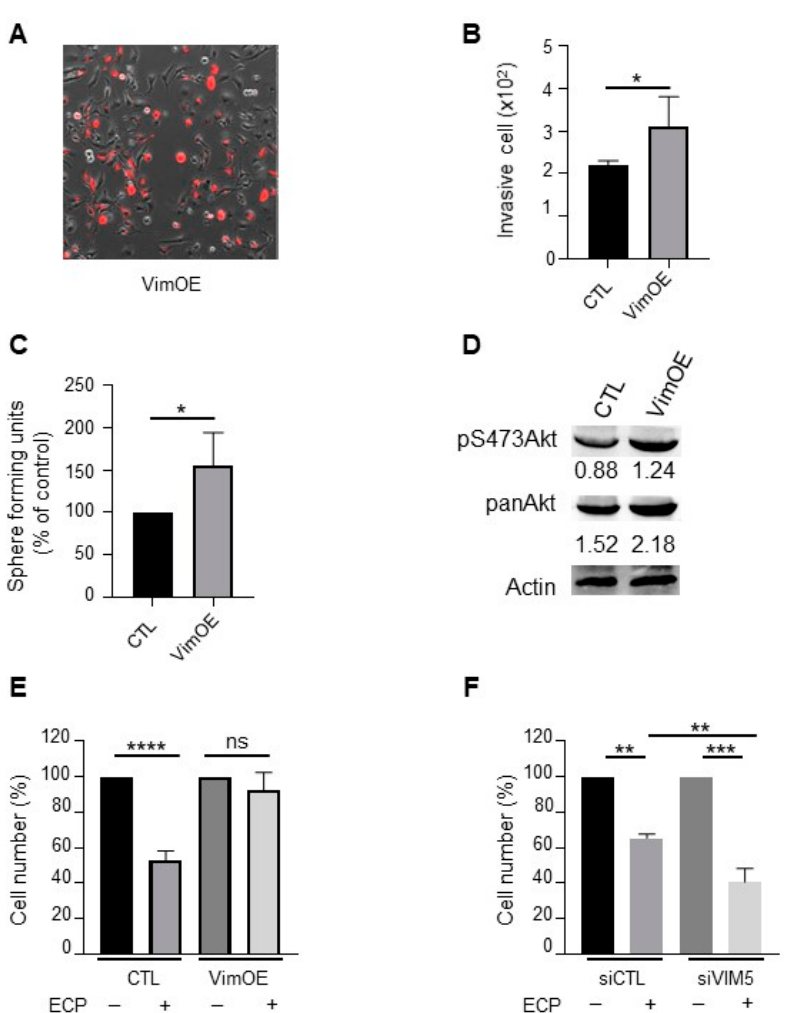
Figure 6. Effect of vimentin overexpression on invasion, sphere formation, Akt activation and